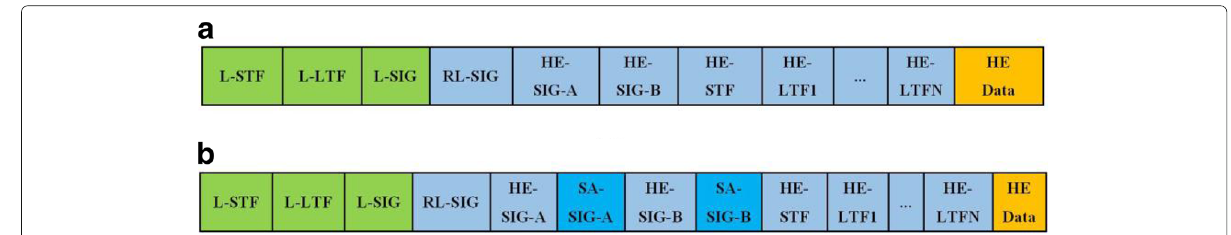
Fig. 5 Frame format: a HE MU PPDU format in IEEE 802.11ax and b the proposed SA-HE